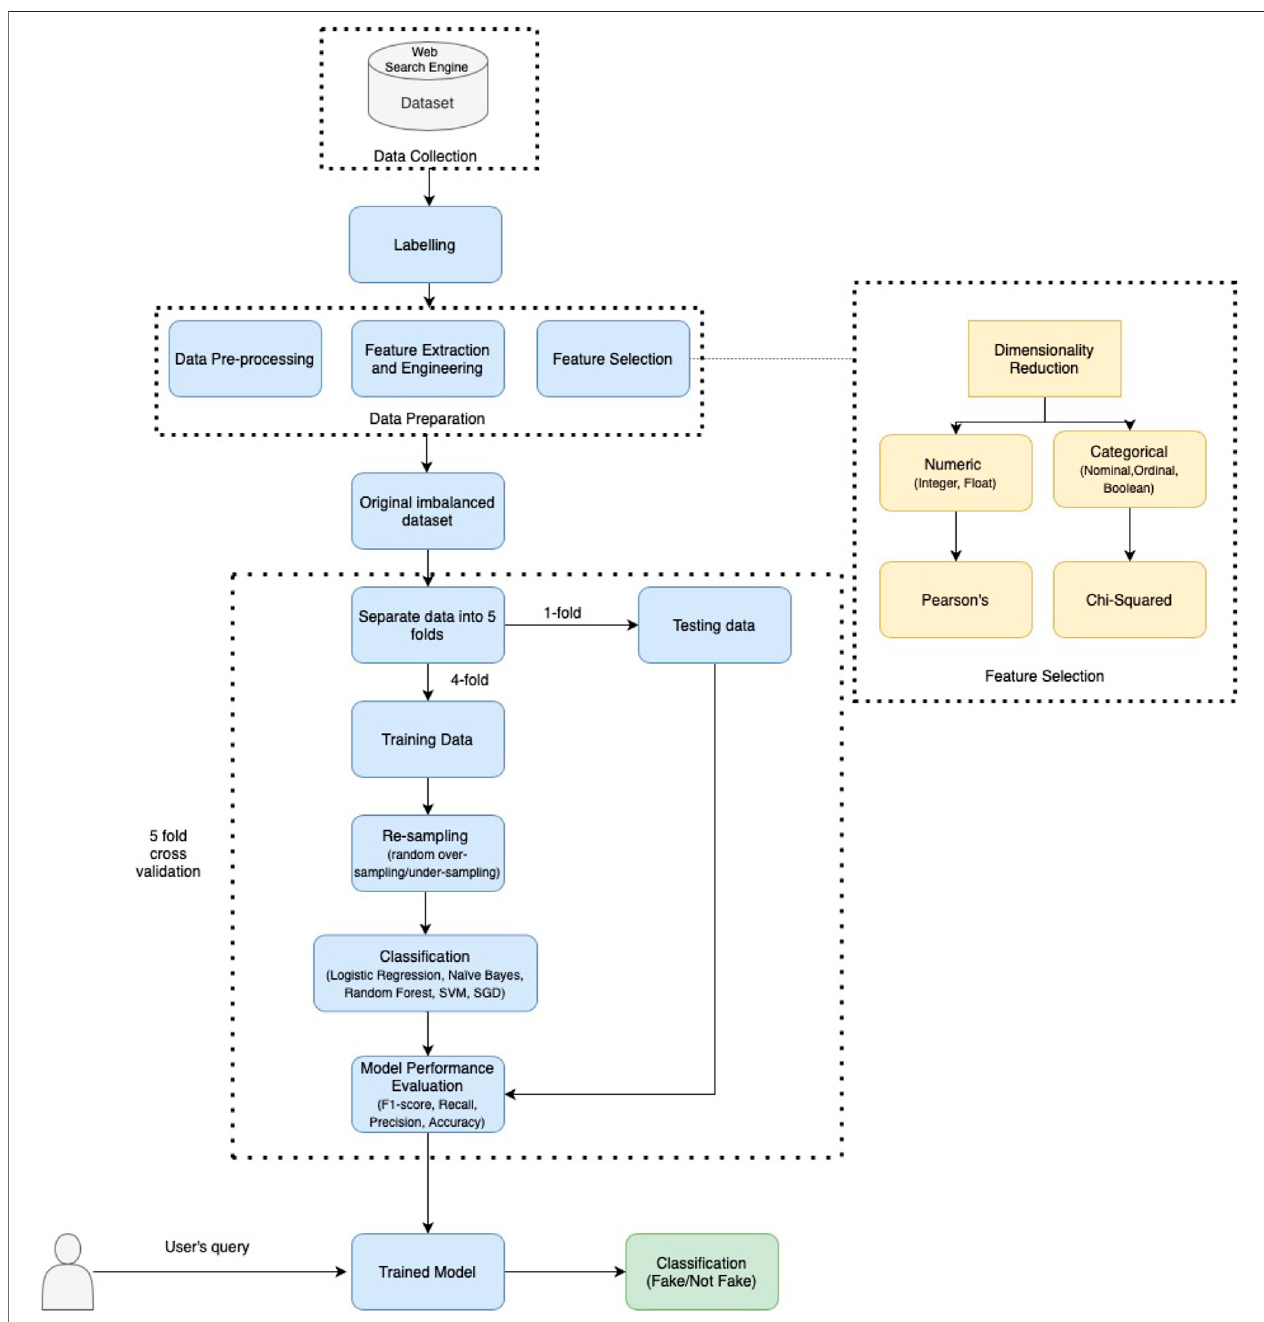
FIGURE 2 | Machine learning work fl ow for training algorithms and classi fi cation of results from web search engines (WSEs). A KNN imputation algorithm and MinMaxScalar were used to rescale variables. However, the percentage of missing values in the dataset was very low ( < 1%). Since high correlation among features leads to redundancy of features and instability of the model, statistical tests, such as chi-squared and Pearson ’ s correlation coef fi cient, were used for feature selection. ThecorpuscollectedfromWSEswas,therefore,pre-processedbeforebeingusedasaninputfortrainingthemodels.Duetotheclassimbalanceinthedataset,re- sampling techniques were applied to the training set only, during cross-validation ( k -fold (cid:1) 5). Different classi fi cation models were then evaluated by scoring the classi fi cation outcomes from a testing set, in terms of the following performance metrics: F1 score, recall, accuracy, and precision.